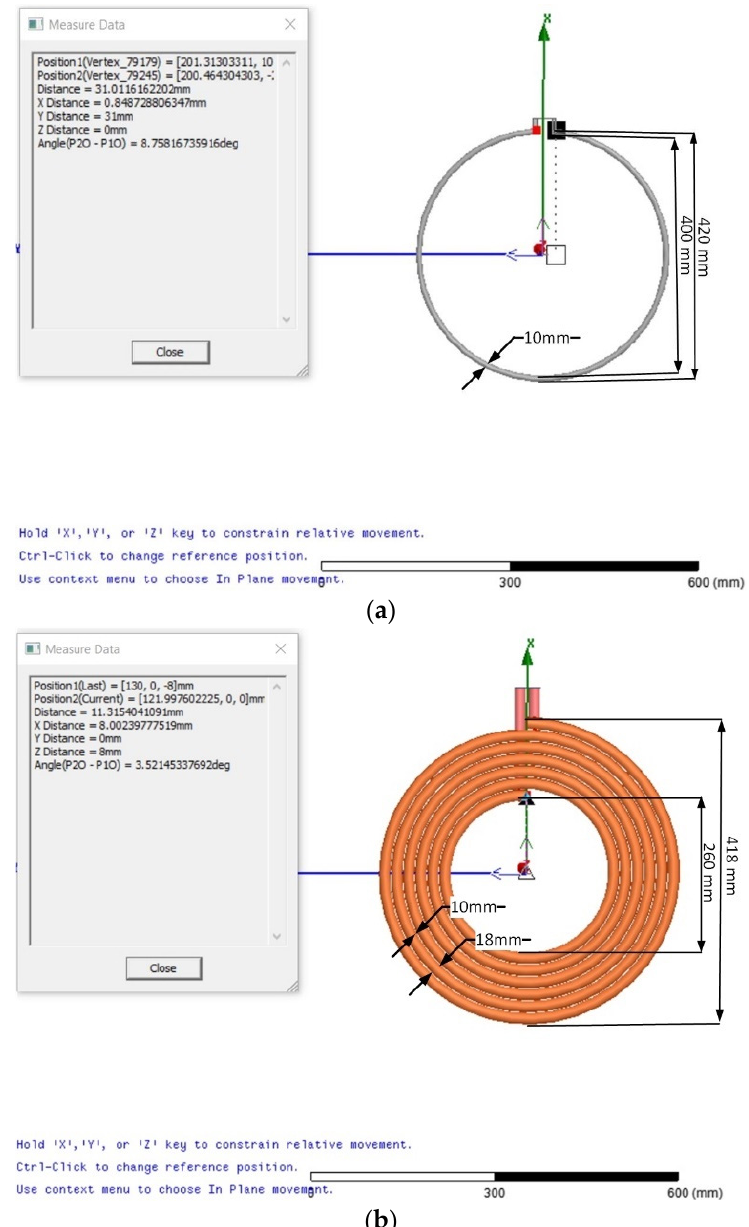
Figure 2. Designed coils to charge the drone’s battery: ( a ) receiver coil, STLAC; and ( b ) transmitter coil,